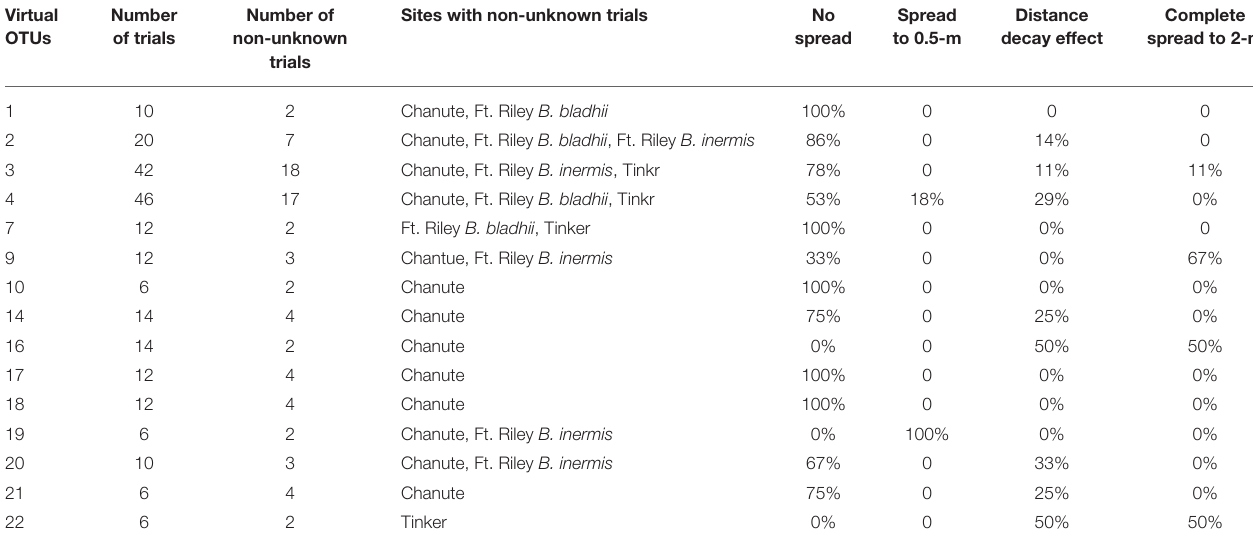
Sites with non-unknown trials No